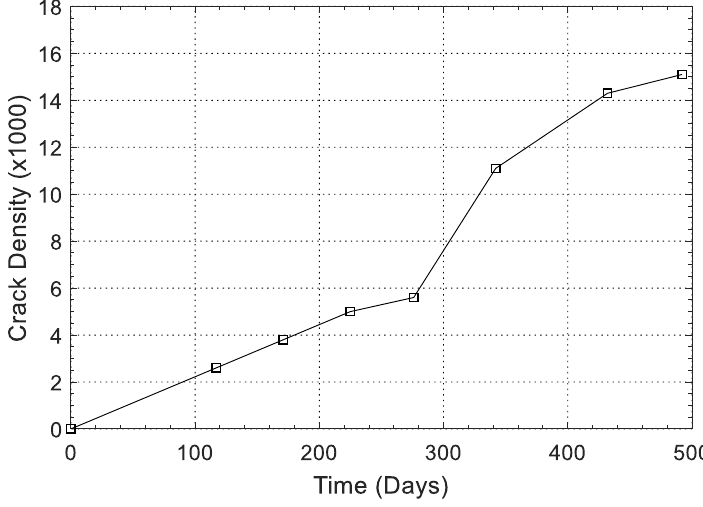
Figure 9. Crack density versus time for the CaCl 2 -4 specimen of the larger batch series.